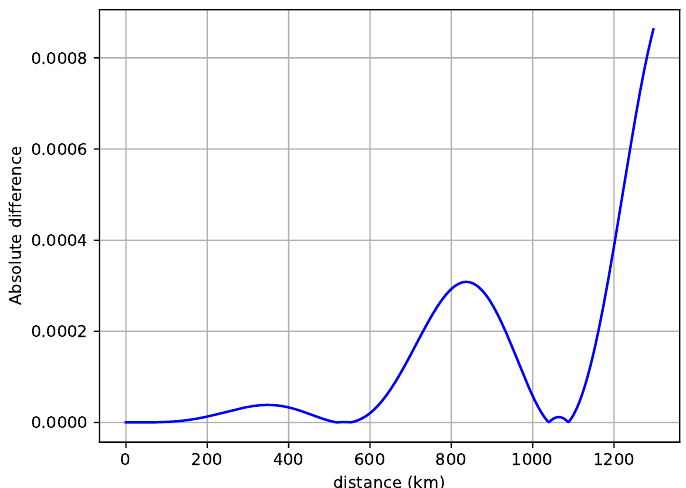
Figure 4. Absolute difference between the probability of electron neutrino appearance calculated with the iteration method described in the text and the “exact” eigenvalues method. A constant matter density of 2.8 g/cm 3 and a muon neutrino beam of 0.5 GeV was